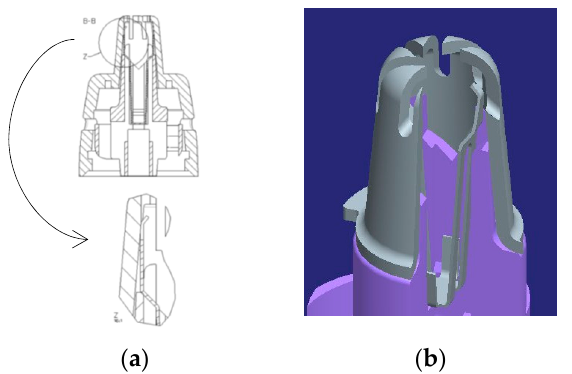
Figure 5. Cross-section of the new cutting system with an innovative inner blade set. ( a ) Drawing; ( b ) illustration.